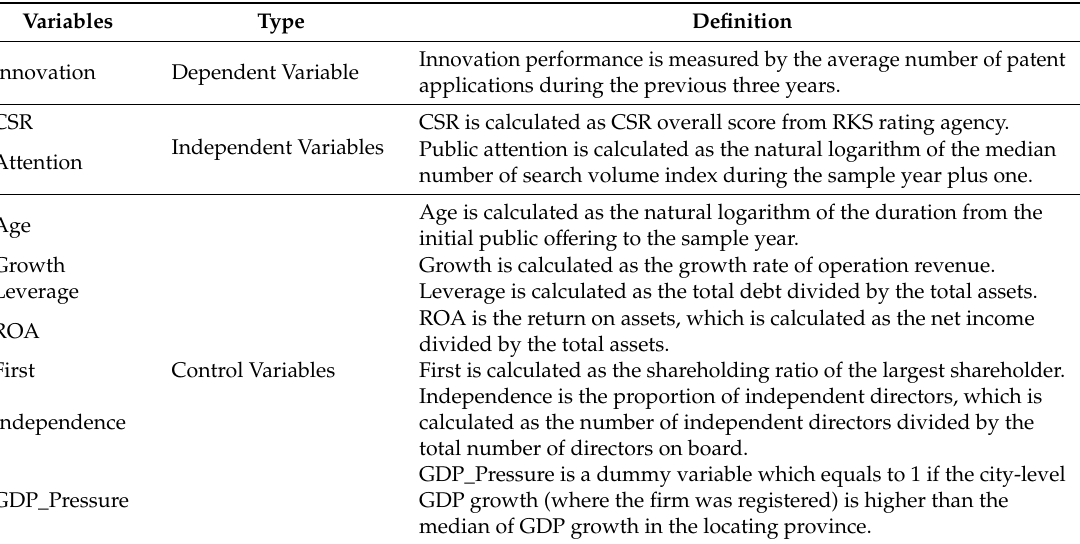
Table 1. Variable